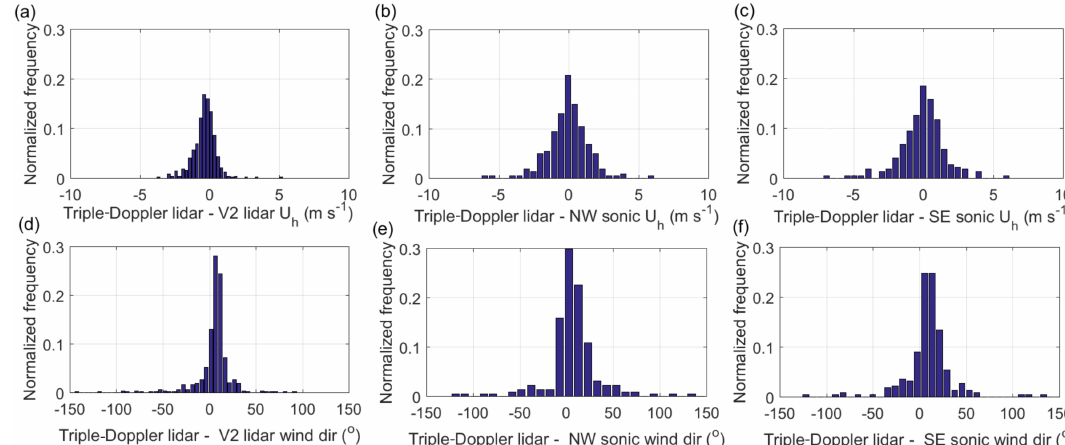
Figure 9. Difference of triple-Doppler lidar retrieval with reference instruments for all the tested heights: (a–c) horizontal wind speed U h (ms − 1 ) ; (d–f) wind direction ( ◦